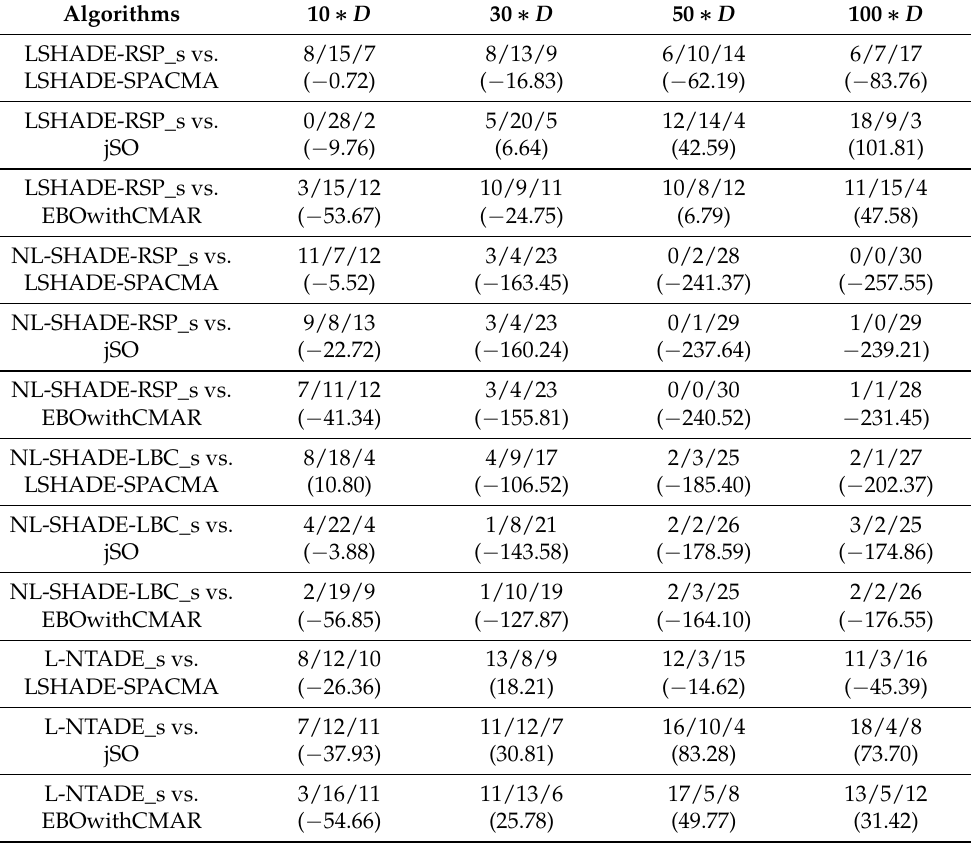
Table 7. Algorithms with crossover rate sorting vs. alternative approaches, CEC 2017, Mann–Whitney tests and total standard